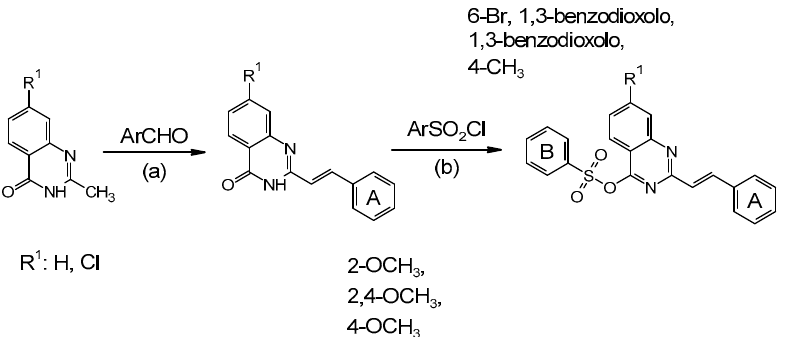
Figure 10. Synthesis pathways of the sulfonic derivatives of styrylquinazolines. ( A ) 2-OCH 3 ; 2,4-OCH 3 ; 4-OCH 3 ; ( B ) 6-Br, 1,3-benzodioxolo; 1,3-benzodioxolo; 4-CH 3 . Conditions: ( a ) AcOH, MW